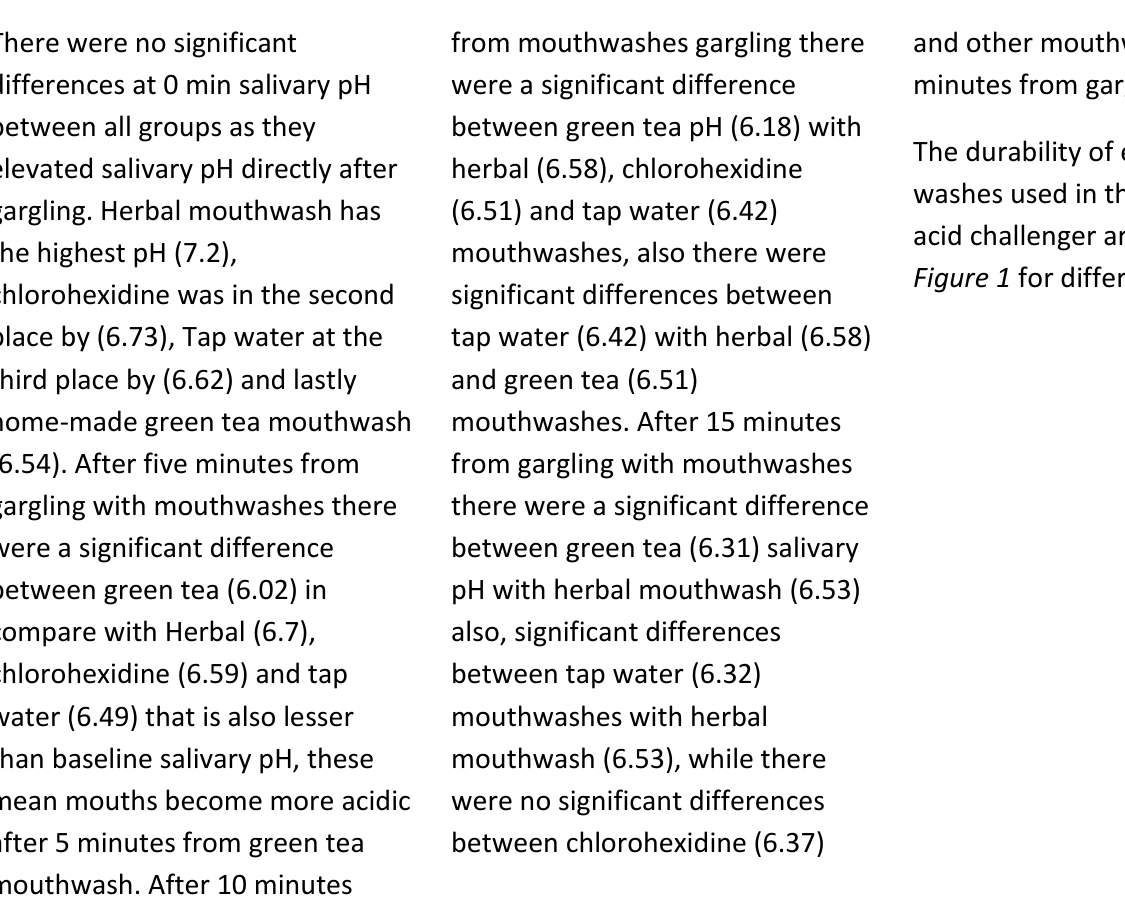
a: homogenous group, b and c: significant differences at p ≤